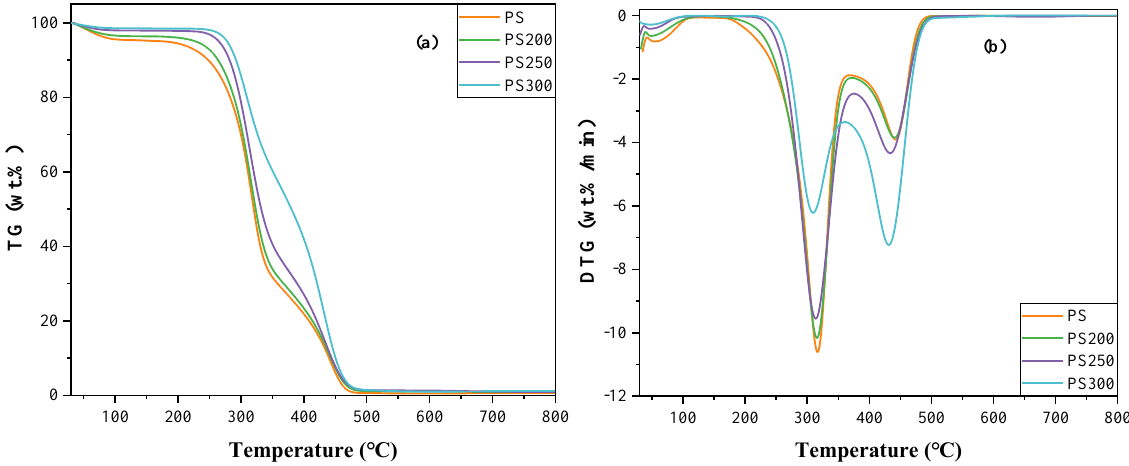
Figure 4. TG and DTG curves for the raw and torrefied PS combustion at 10 ◦ C/min. ( a ) TG; ( b ) DTG.